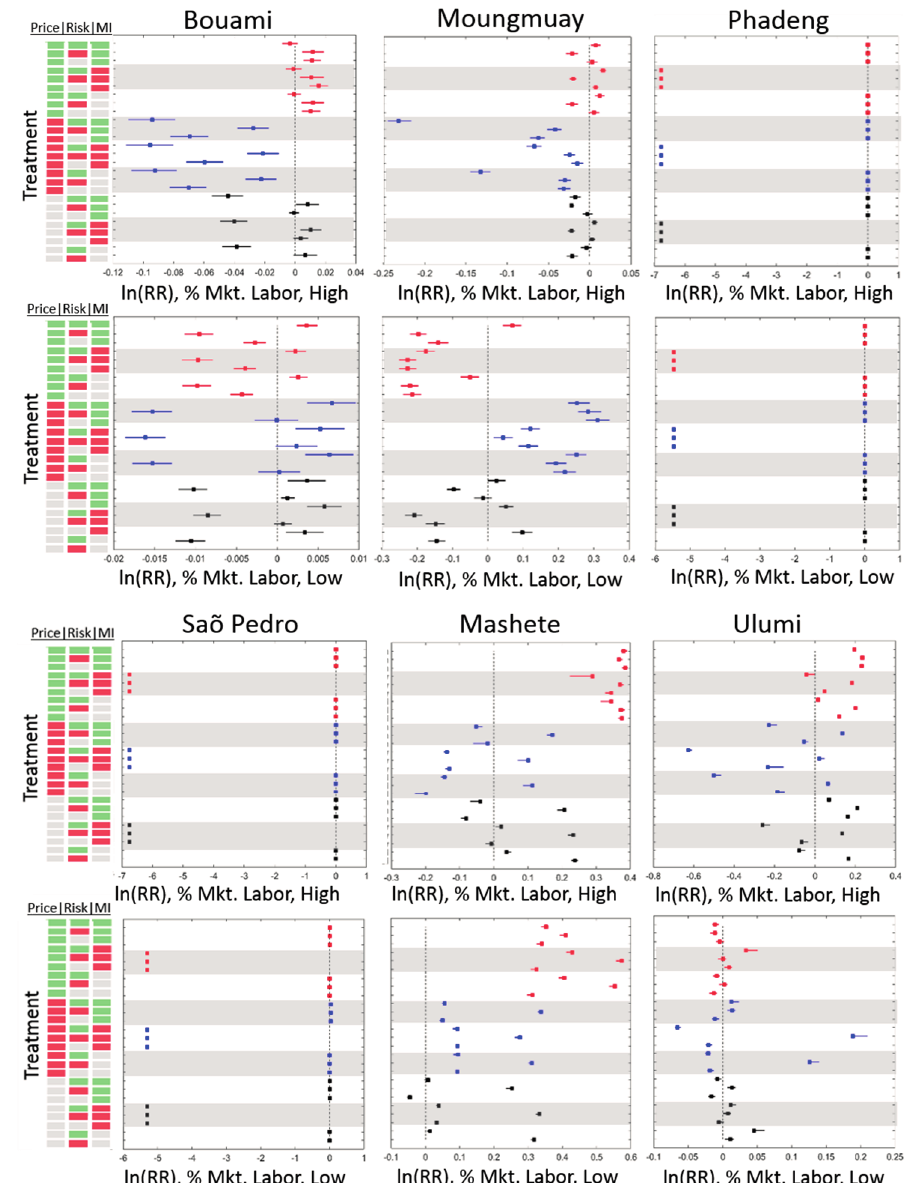
Figure 4. Mean effect sizes of experimental treatments for high (top row) and low (bottom row) market-oriented labor household agents. Experimental treatments are indicated in the color-coded panels on the far left and are displayed as combinations of commodity price (left column), average risk preference (middle column), and market influence (MI, right column) perturbations. Green, gray, and red treatment cells indicate increased, baseline, and decreased treatment values, respectively. Effect sizes are plotted with the mean and 95% confidence interval. Interpretation . Effect sizes are significant at α =0.05 level when intervals do not include zero or do not overlap between categories [73,74]. Within each plot, effect sizes are grouped and colored by commodity price level (red points = higher prices; blue points = lower prices; black points = baseline prices). White and gray bands group experimental treatments by market influence settings. Thus, the relative influence of risk preferences is shown by the amount of horizontal dispersion of points within a white/gray